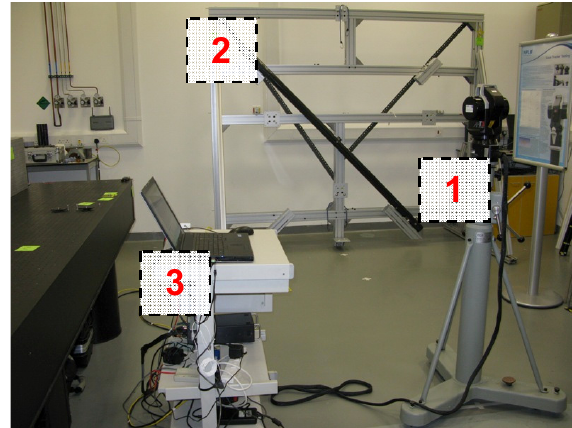
Fig. 2. ASME B89.19.4 tracker verification service at NPL showing (1) tracker, (2) rig and (3) laptop used for data acqui- sition and post